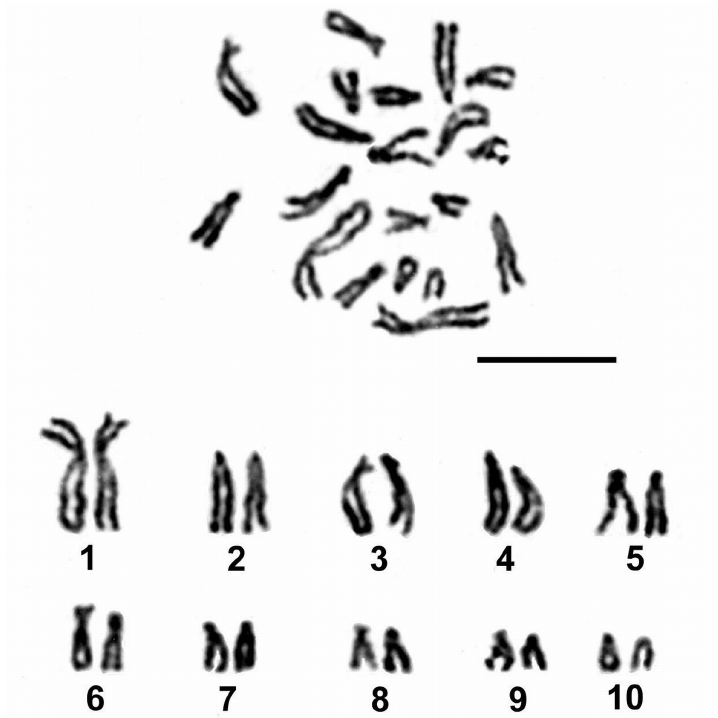
Figure 1. Mitotic metaphase and karyotype of Echinochasmus sp. Bar = 10 Table 1. Morphometric analysis of chromosomes of Echinochasmus sp. Stanevičiūtė, Petkevičiūtė & Kiselienė, 2008.